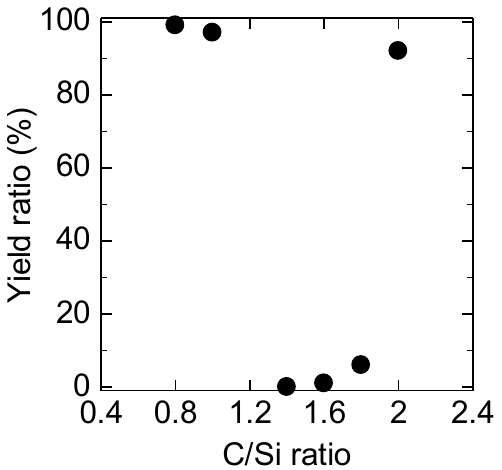
Figure 6. Relationship between yield and C/Si ratio obtained from the PL images shown in Figure